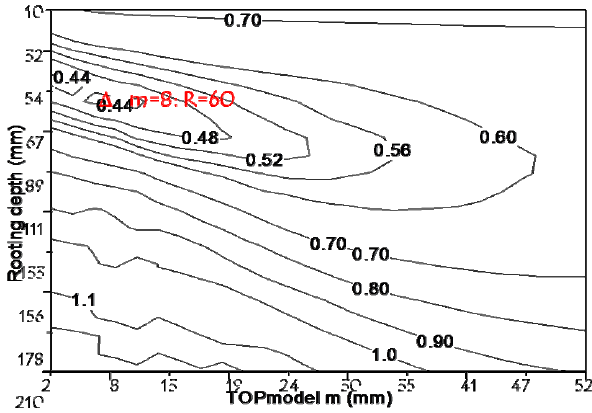
Fig. 4a. RMS mean difference between observed and simulated flow duration curves for R. Hozgarganta, S. Spain. The optimal set of model parameters are shown as 1 . Figure 3b. Average normalised departure averaged across five test catchments from their individual minimum RMS error. ∆ shows global optimum